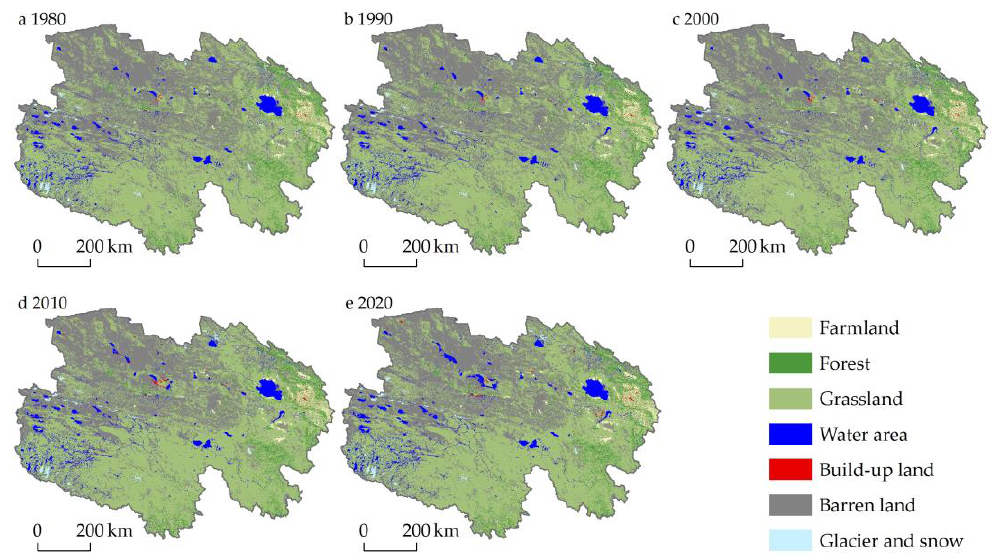
Figure 2. Land use of Qinghai Province from 1980 to 2020.